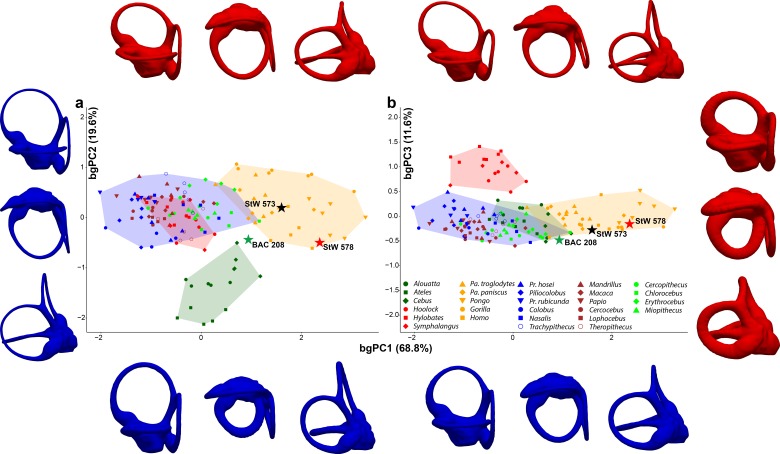
Main patterns of vestibular shape variation among the analyzed anthropoid sample as shown by bivariate plots of principal components from the between-group principal components analysis (bgPCA) using a few major clades (i.e., platyrrhines, cercopithecoids, hylobatids and hominids) as grouping factor.(a) bgPC2 vs. bgPC1. (b) bgPC3 vs. bgPC1. Variance explained by each bgPC is included within parentheses. Color code: dark green, platyrrhines; orange, hominids; red, hylobatids; brown, papionins; green, cercopithecins; blue, colobines. Colored stars correspond to: green, Oreopithecus; black, Australopithecus sp. (StW 573); red Australopithecus sp. (StW 578). Lateral (top/left), superior (middle), and posterior (bottom/right) views of deformation maximum (red) and minimum (blue) conformations for each bgPC are shown along each axis. Hominids are distinguished from hylobatids and cercopithecoids along bgPC1 (positive vs. mostly negative values, respectively), which is mainly driven by the volumetric proportions of the SCs and by their size relative to that of the vestibular recesses. bgPC2, driven by the size of the anterior and posterior SCs relative to the lateral one, distinguishes platyrrhines (more negative values) from catarrhines. Hylobatids (on positive values) differ from all other anthropoids along bgPC3 due to the reduced and posteriorly tilted posterior SC, as well as by the relative orientation among the canals. Oreopithecus does not match the variability of extant anthropoids as its morphology shows a mosaic of primitive and derived features. The two Australopithecus specimens match instead the range of extant hominids, with StW 573 being most similar to Pan, while StW 578 to Homo.Figure 2—source data 1.Individual scores for all the principal components (bgPC) yielded by the between-group principal components analysis (bgPCA) of deformation-based 3DGM of vestibular shape for anthropoids, using major taxa (i.e., hominids, hylobatids, cercopithecoids, and platyrrhines) as grouping factor.The variance explained by each bgPC is reported within parentheses. Table provided as a separate Excel file.